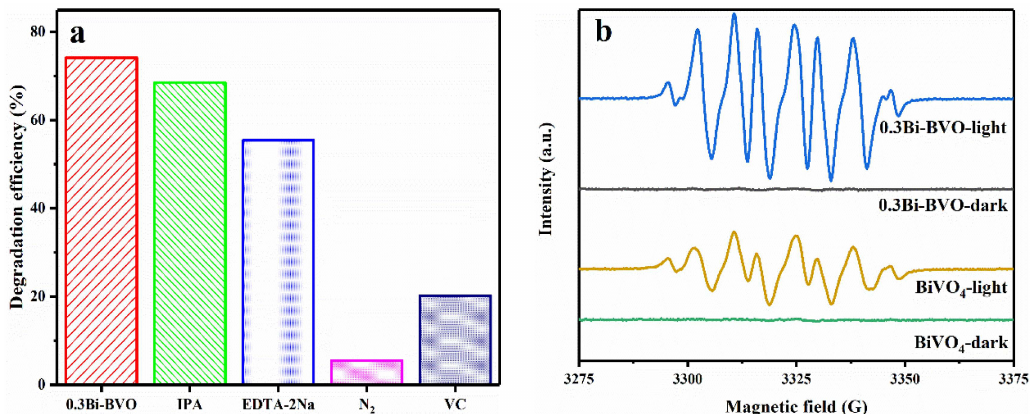
Figure 8. ( a ) Effect of different trapping agents on the photocatalytic degradation of CIP and ( b ) ESR spectra of DMPO- · O 2 − in the dark and under light